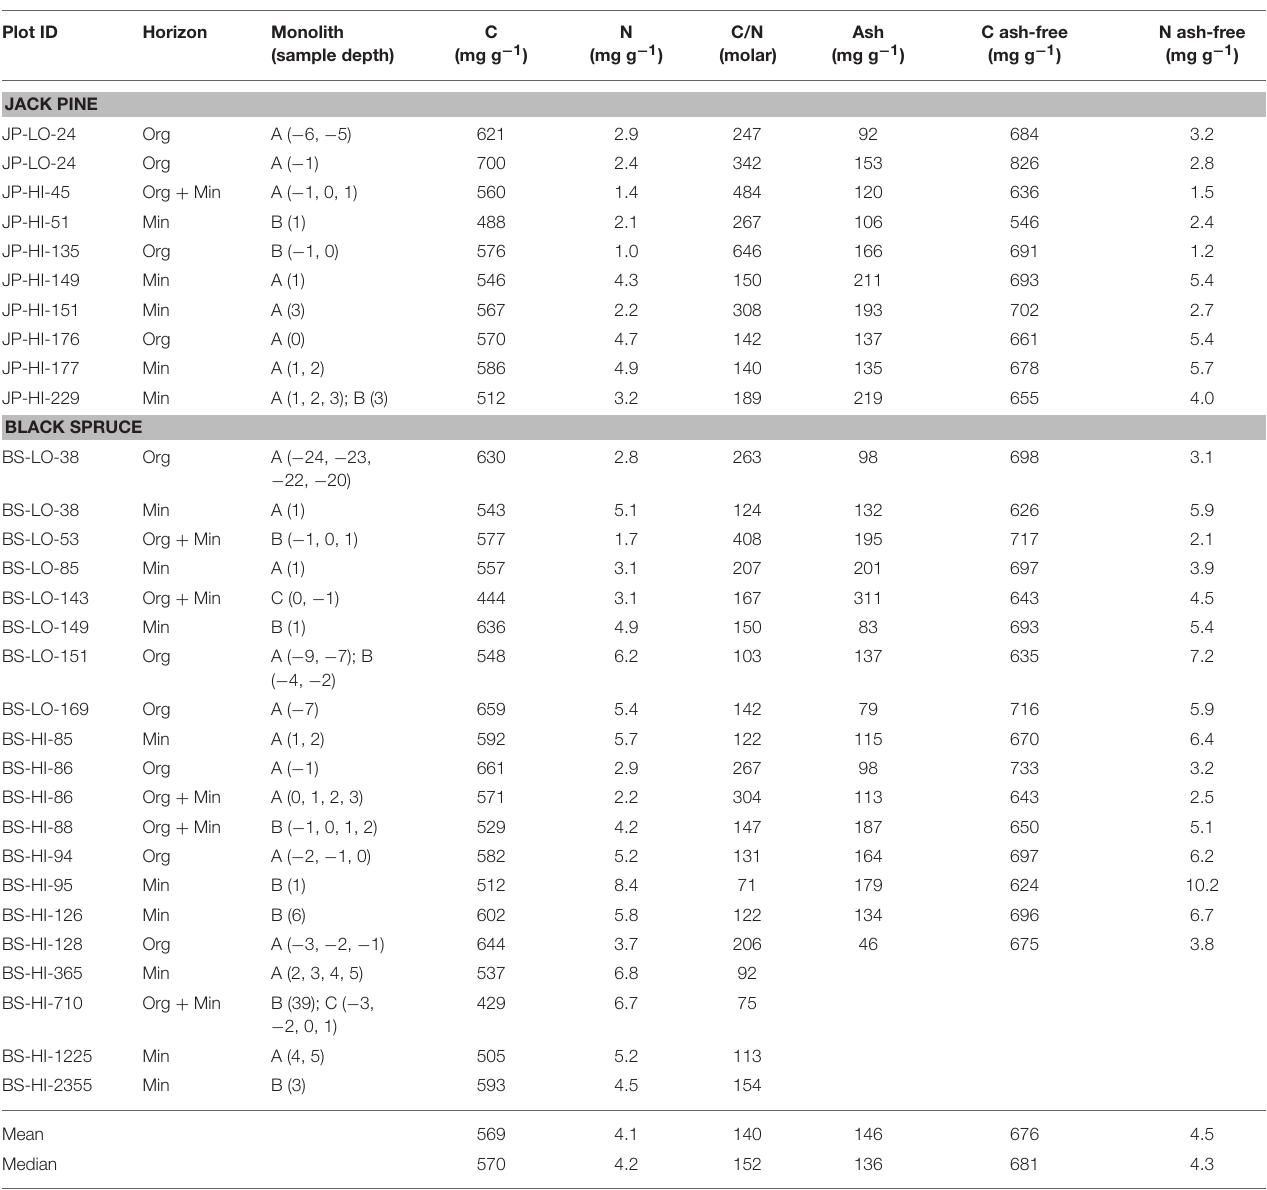
TABLE 2 | Chemical composition of charcoal samples > 2mm extracted from organic (Org) or mineral (Min) horizons. Plot ID Horizon